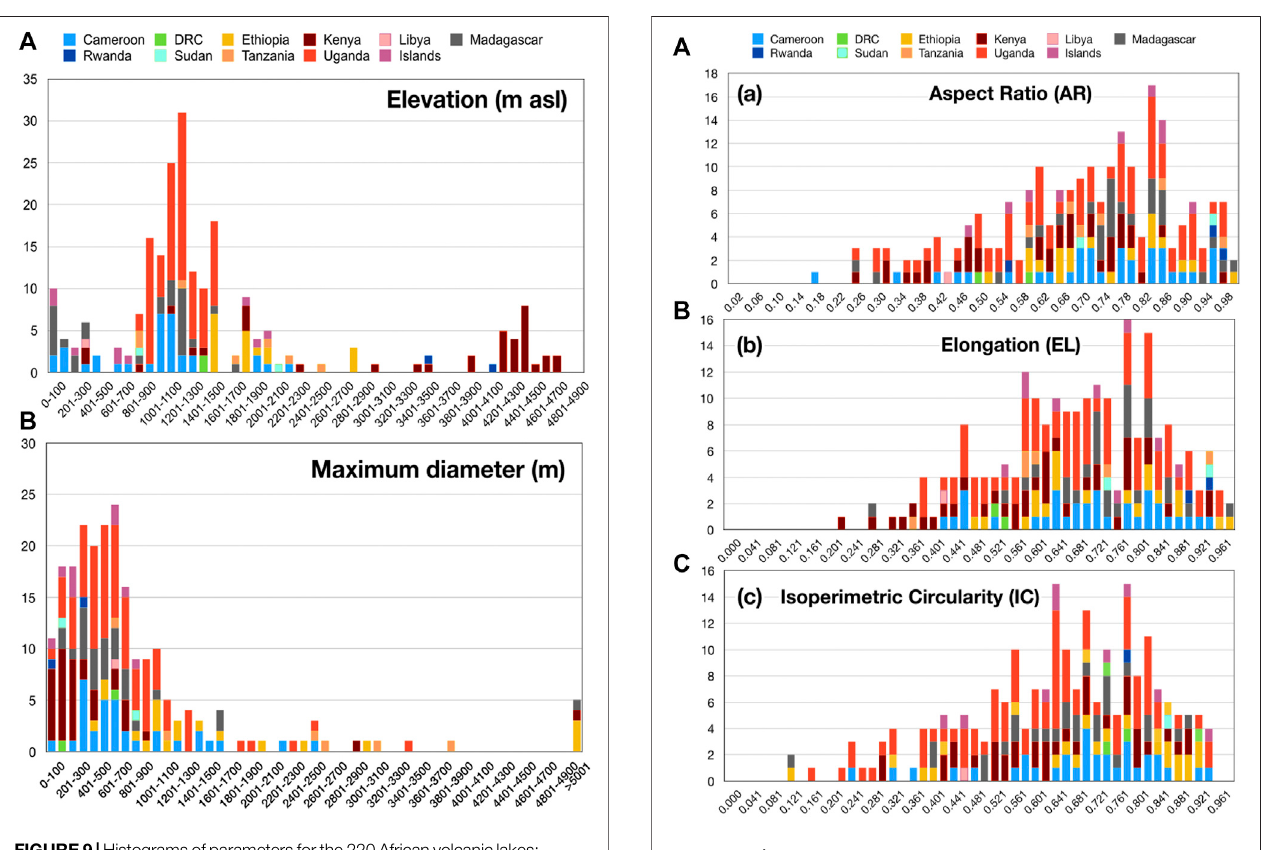
10C represents a similar distribution of